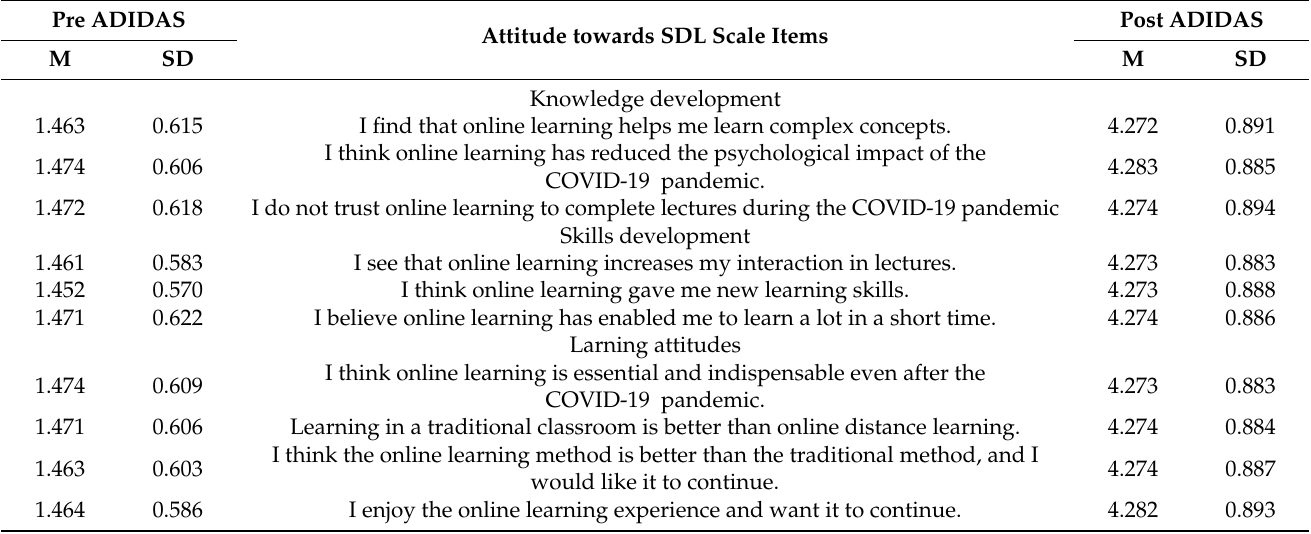
Table 5. Descriptive statistics of students’ attitude towards SDL pre- and post-ADIDAS model.